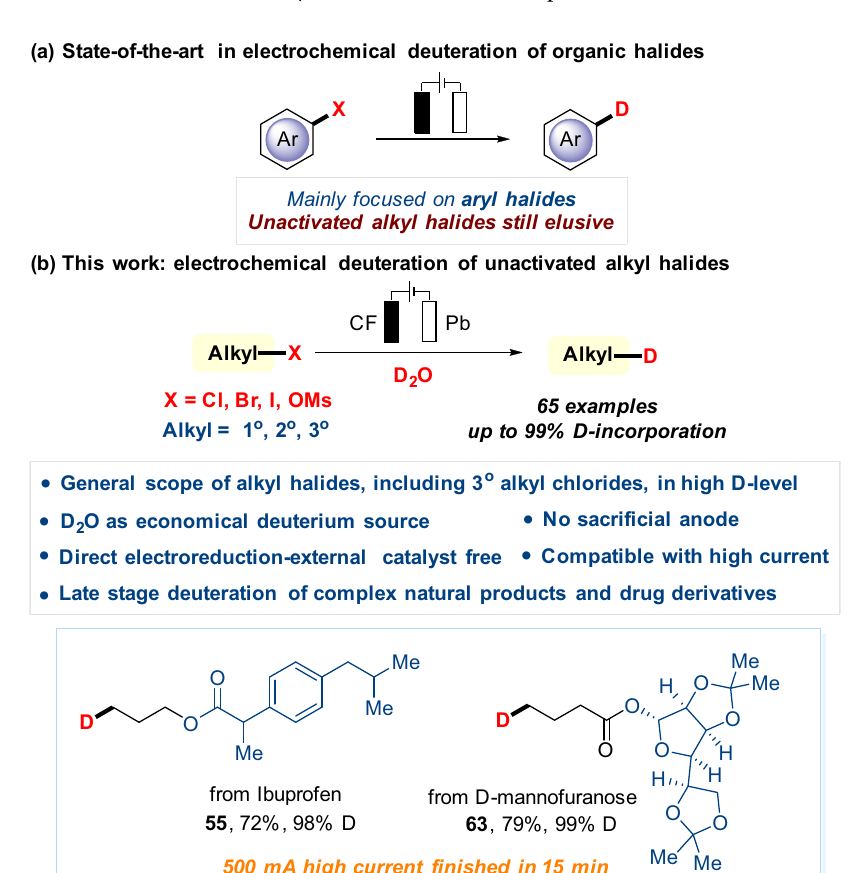
Fig. 1 Electrochemical deuteration of organic halides. a State-of-the-art in electrochemical deuteration of organic halides. b A facile and general electrochemical deuteration of unactivated alkyl